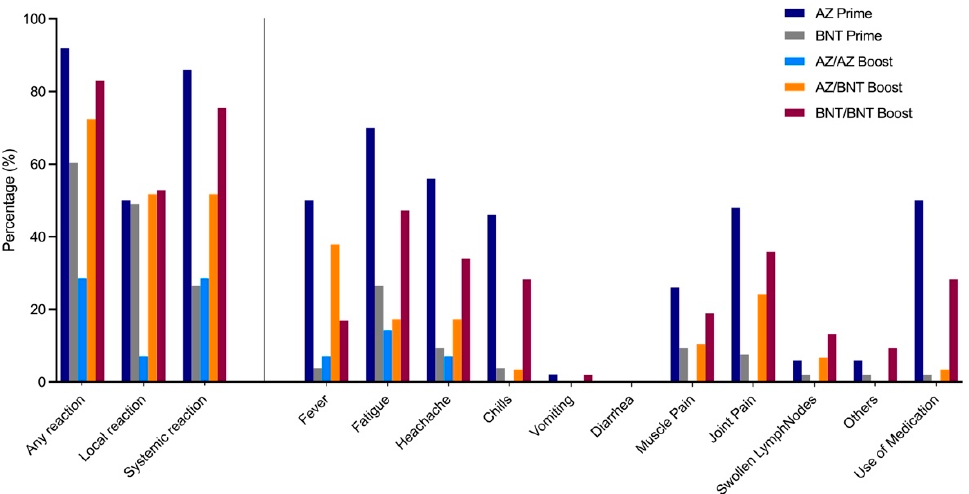
Figure 4. Local and systemic reactions in health care workers after AZ or BNT priming dose or homologous AZ/AZ, heterologous AZ/BNT, or homologous BNT/BNT vaccination.